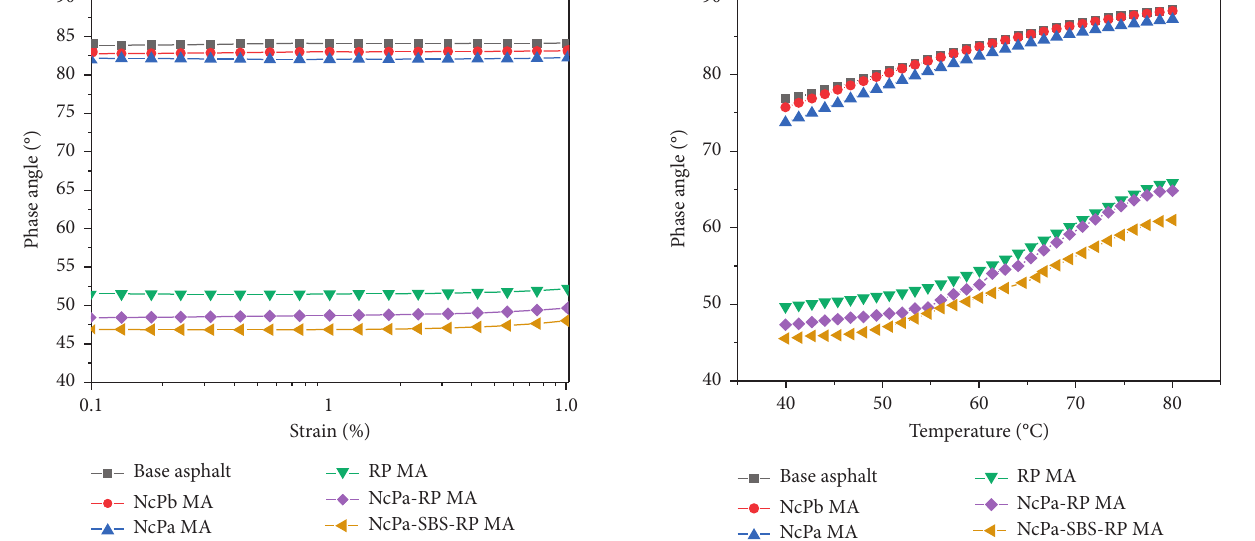
Figure 7: Phase angle versus